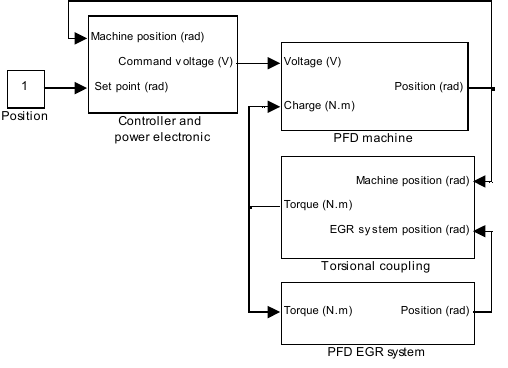
Figure 18. Actuator and EGR system coupling.